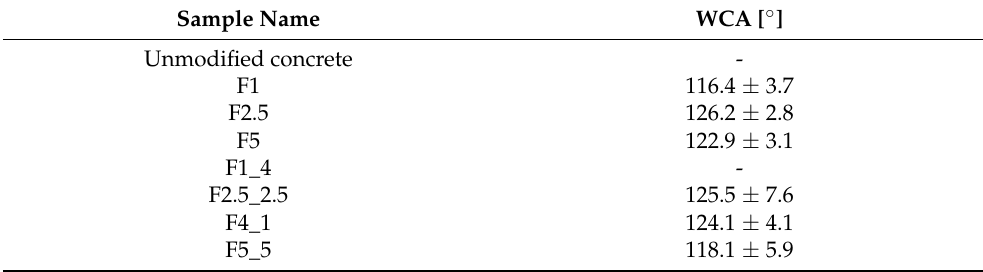
Table 2. Water contact angle (WCA) values of concrete without and with OPTES